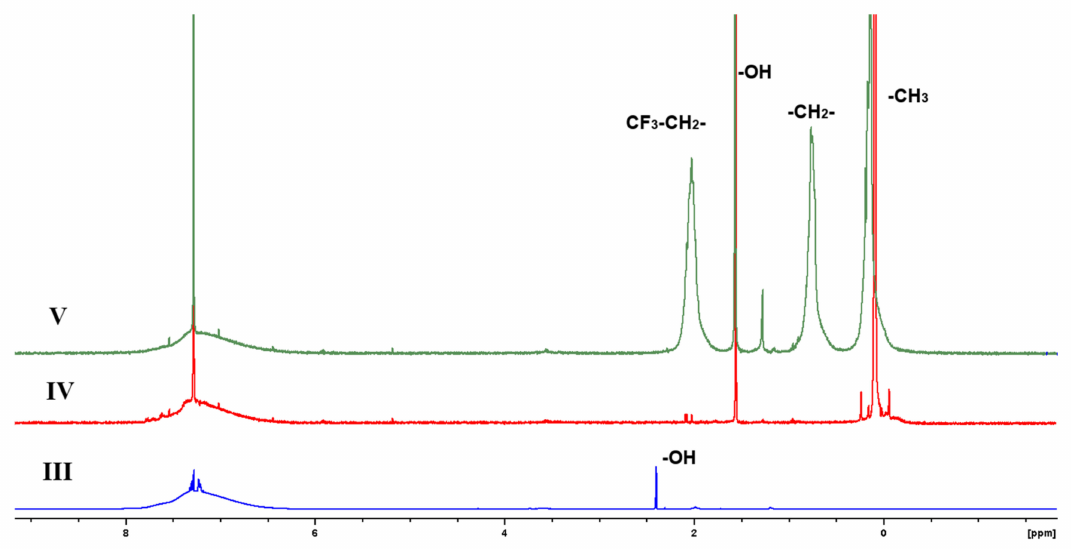
Figure 2. Solution 1 H NMR spectra of III, IV and V in CDCl 3 . The presence of defects in this block was confirmed by solution 13 C NMR spectra (Figure 3).